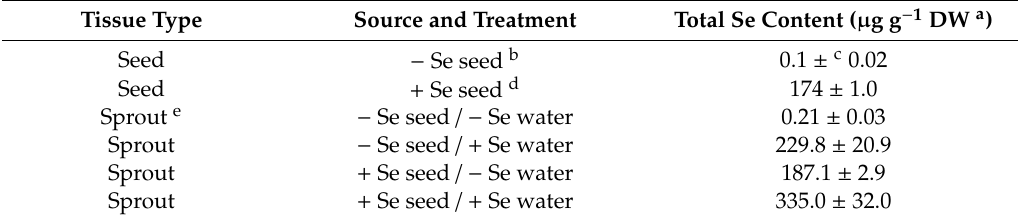
Table 1. Total mean selenium (Se) content in Raphanus sativus cv. ‘Rambo’ seed sourced from control and Se-fertilised plants, and in 5-day-old sprouts produced from the same seed following germination in the presence or absence of